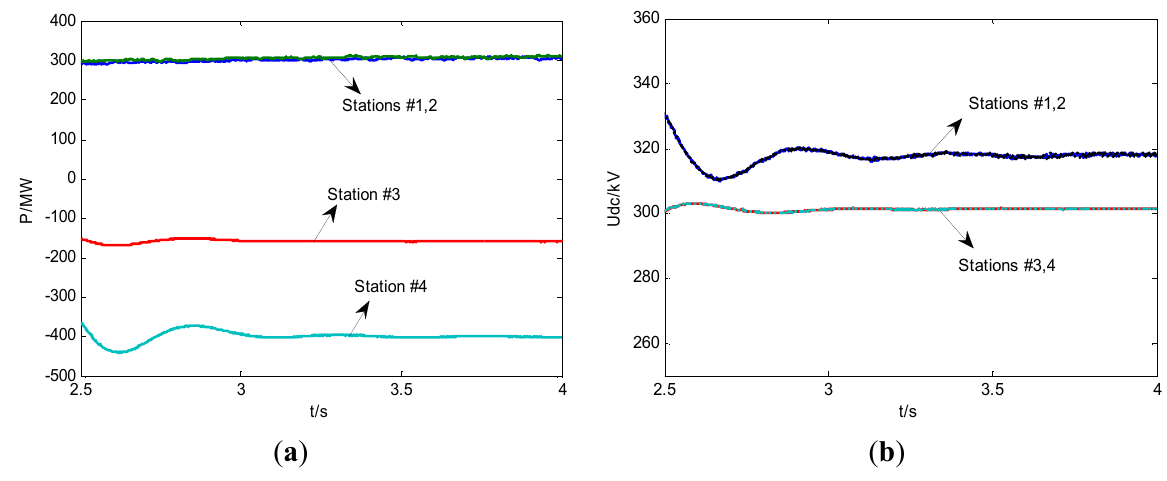
Figure 11. Dynamic response of normal operation ( a ) Active power ( b ) DC side